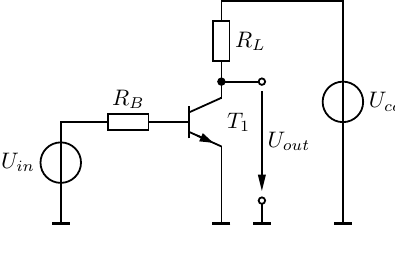
Figure 11: BJT inverter circuit Table 1: Parameters for BJT inverter in Fig. 11 Symbol